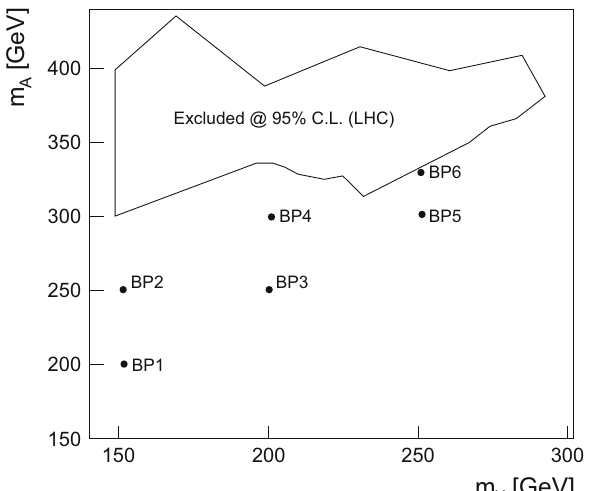
mass. Starting from any of the selected BPs, BR( A → Z H